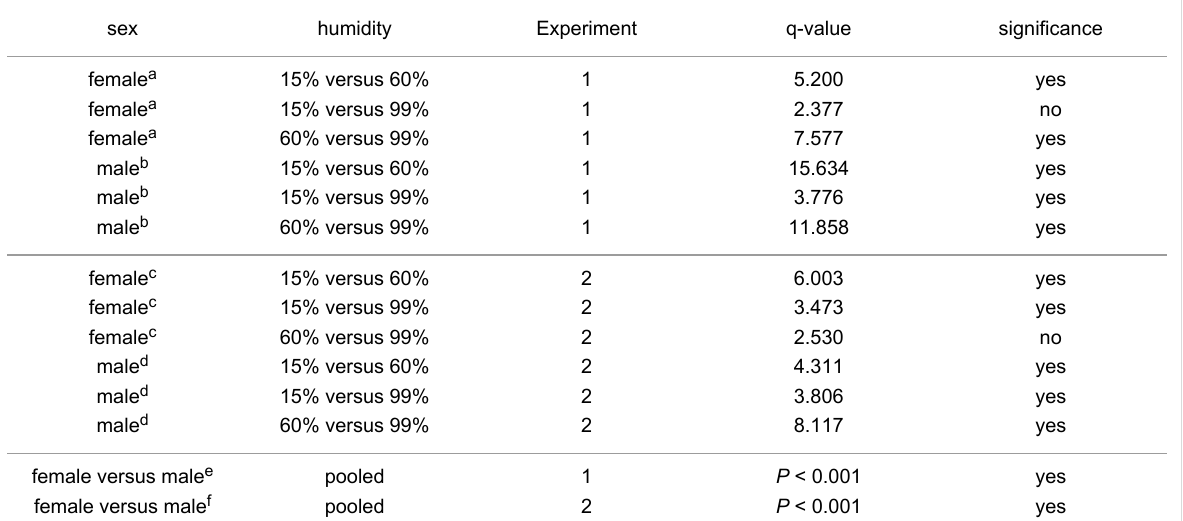
Table 1: Statistics of the traction force measurements.